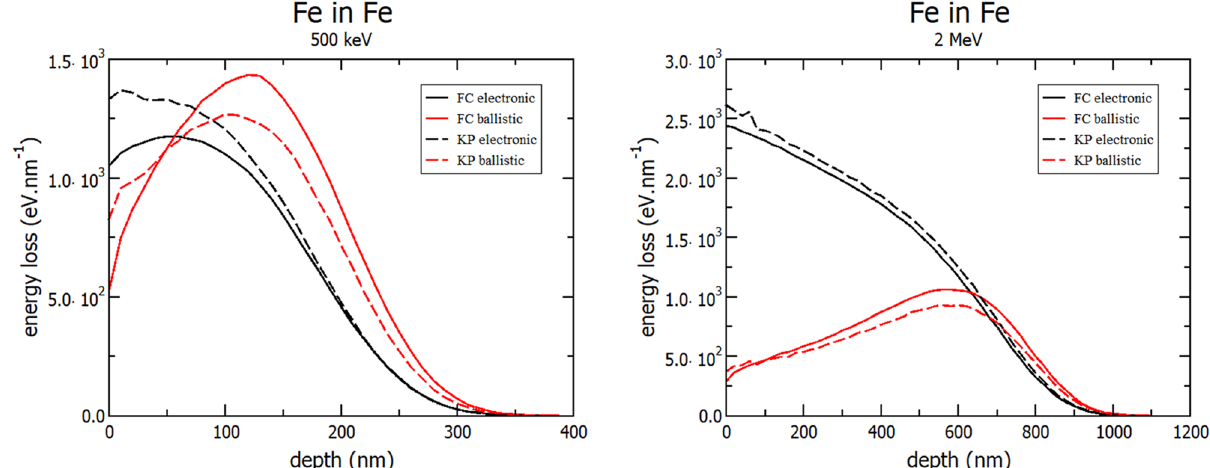
Fig. 4. Energy deposition for 500keV and 2MeV self-irradiation in